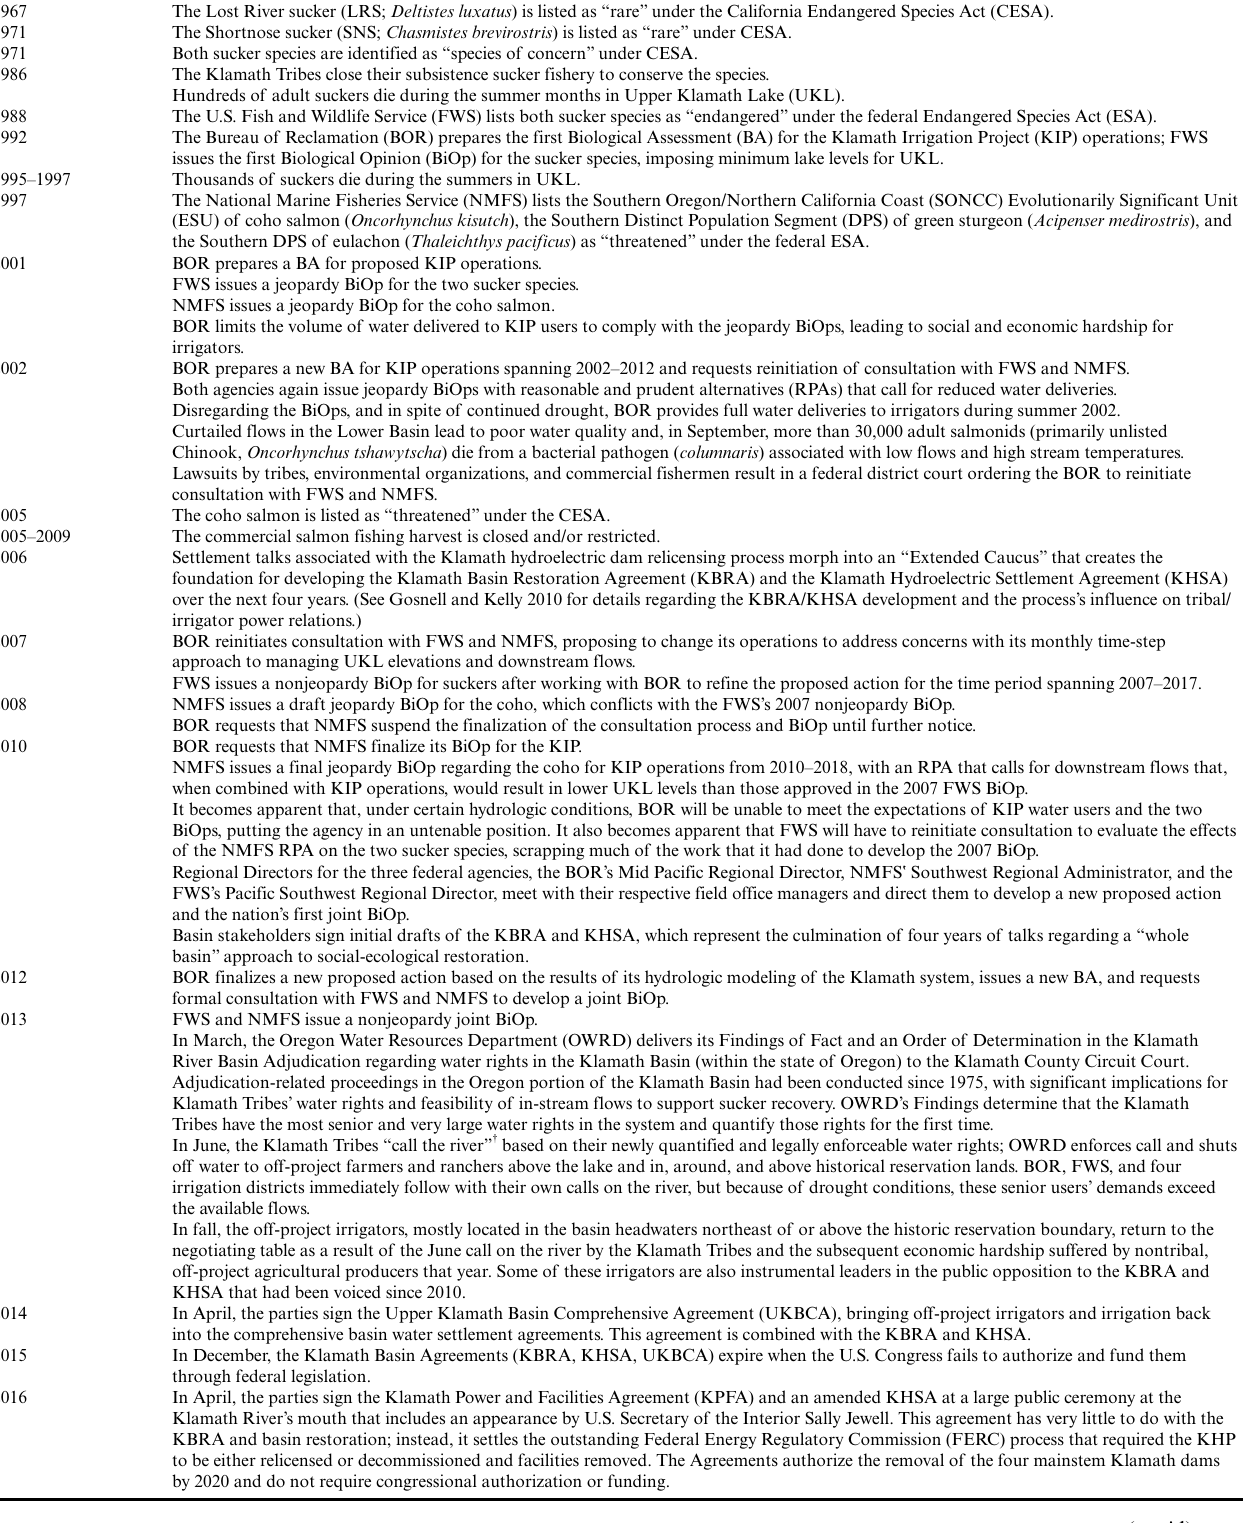
Table 1 . Chronology of events related to implementation of Section 7 of the Endangered Species Act in the Klamath Basin.